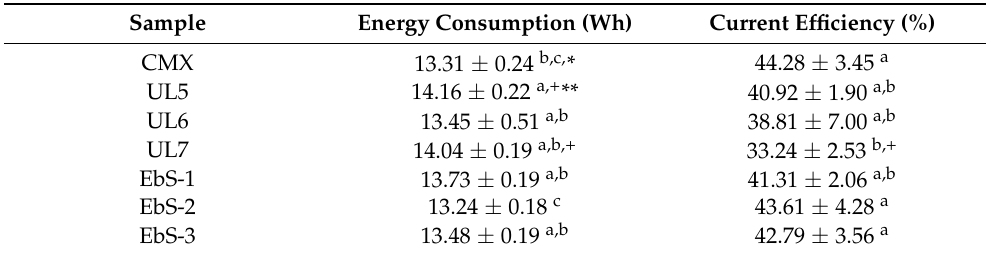
Table 6. Energy consumption and current efficiency of all electrodialysis experiments using hIEMs or